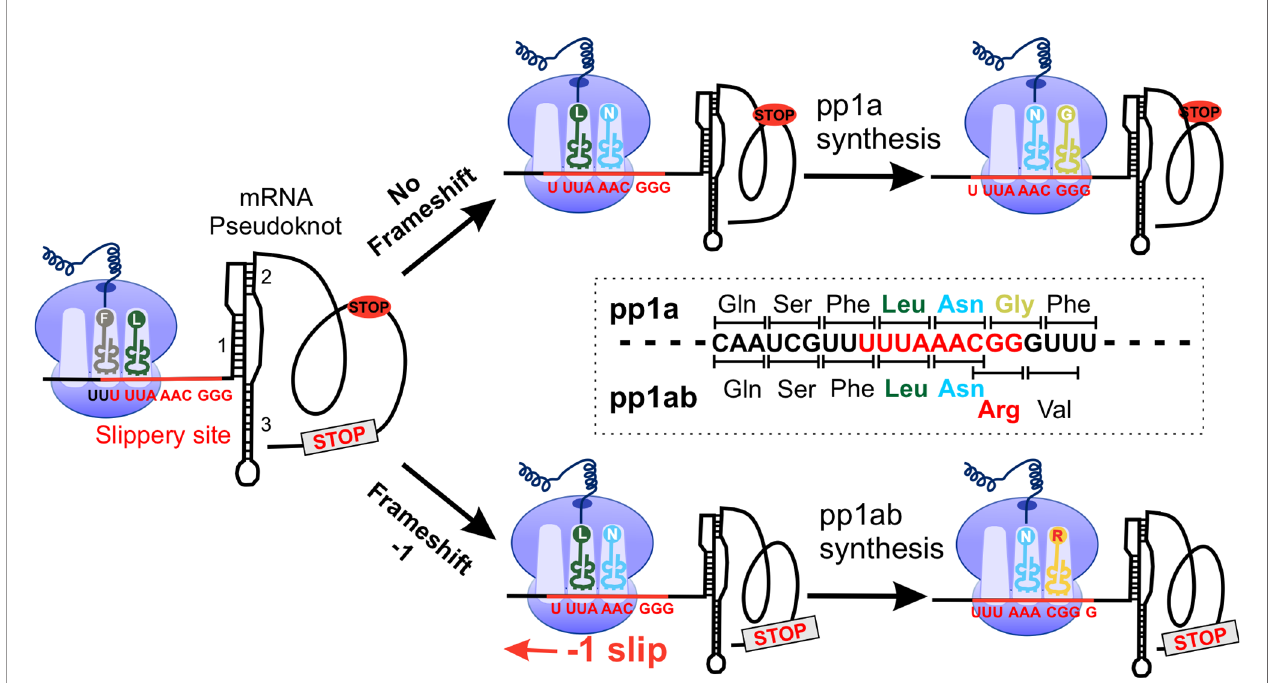
FIGURE 2 | SARS-CoV-2 -1 programmed frameshifting model. The SARS-CoV-2 mRNA pseudoknot interacts with the ribosome, generating tension in the mRNA and pausing translation before the slippery site. After converting “ U_UUA_AAC ” to “ UUU_AAA_C ” , translation was resumed at the codon CGG (Arg), resulting in full- length pp1ab. pp1a, polyprotein